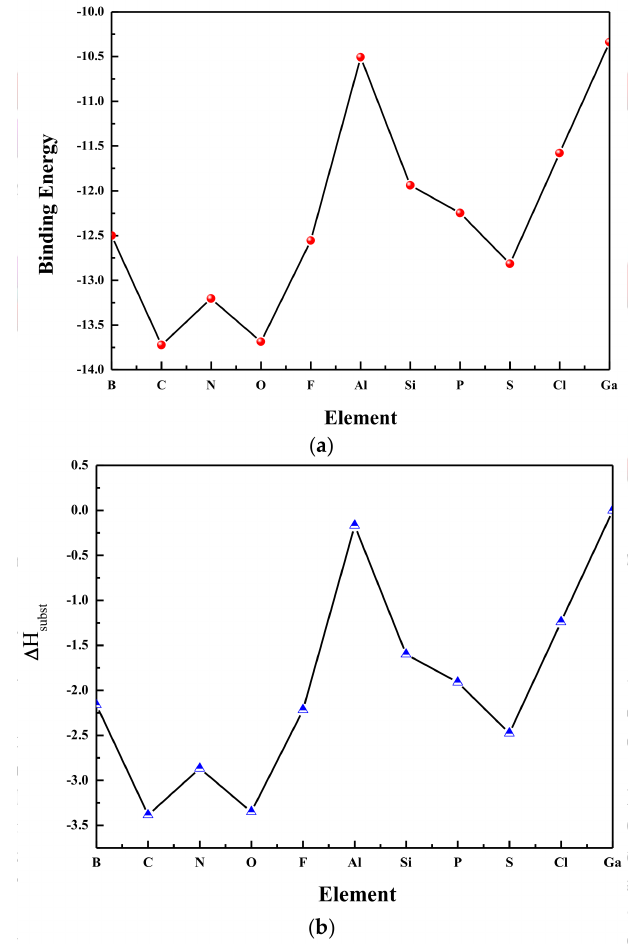
Figure 2. ( a ) Binding energies and ( b ) ∆ H subst of substituted gallium clusters (Ga 5 X)